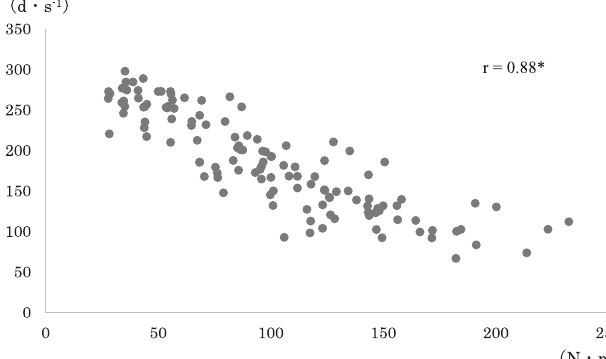
Figure 4 Comparison of maximum torque before and after modification of the leg extension machine.